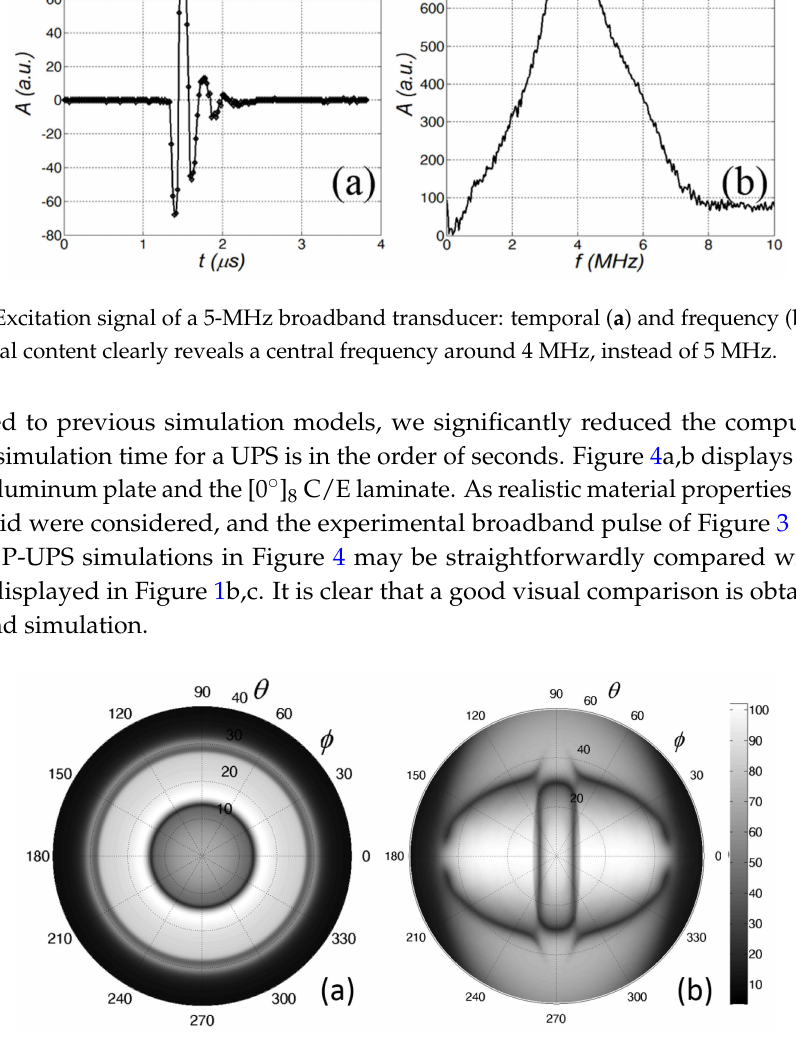
Figure 4. P-UPS simulation (ultrasound pulse of Figure 3 is used as input) for aluminum ( a ) and [0 ˝ ] 8 C/E laminate ( b